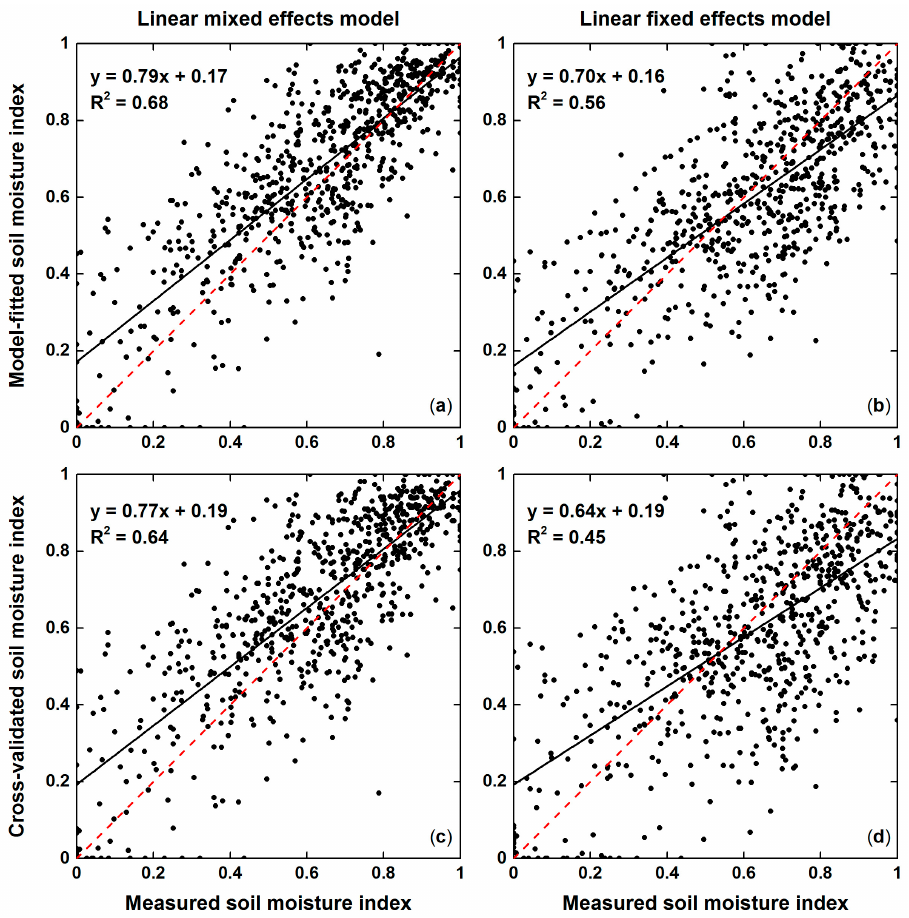
Figure 5. Scatter plots of measured versus predicted soil moisture indices. ( a , c ) are model-fitting and cross-validation results for the LME model, respectively; ( b , d ) are model-fitting and cross-validation results for the linear fixed effects model, respectively. The solid black line and dashed red line represent the regression line and 1:1 line, respectively.